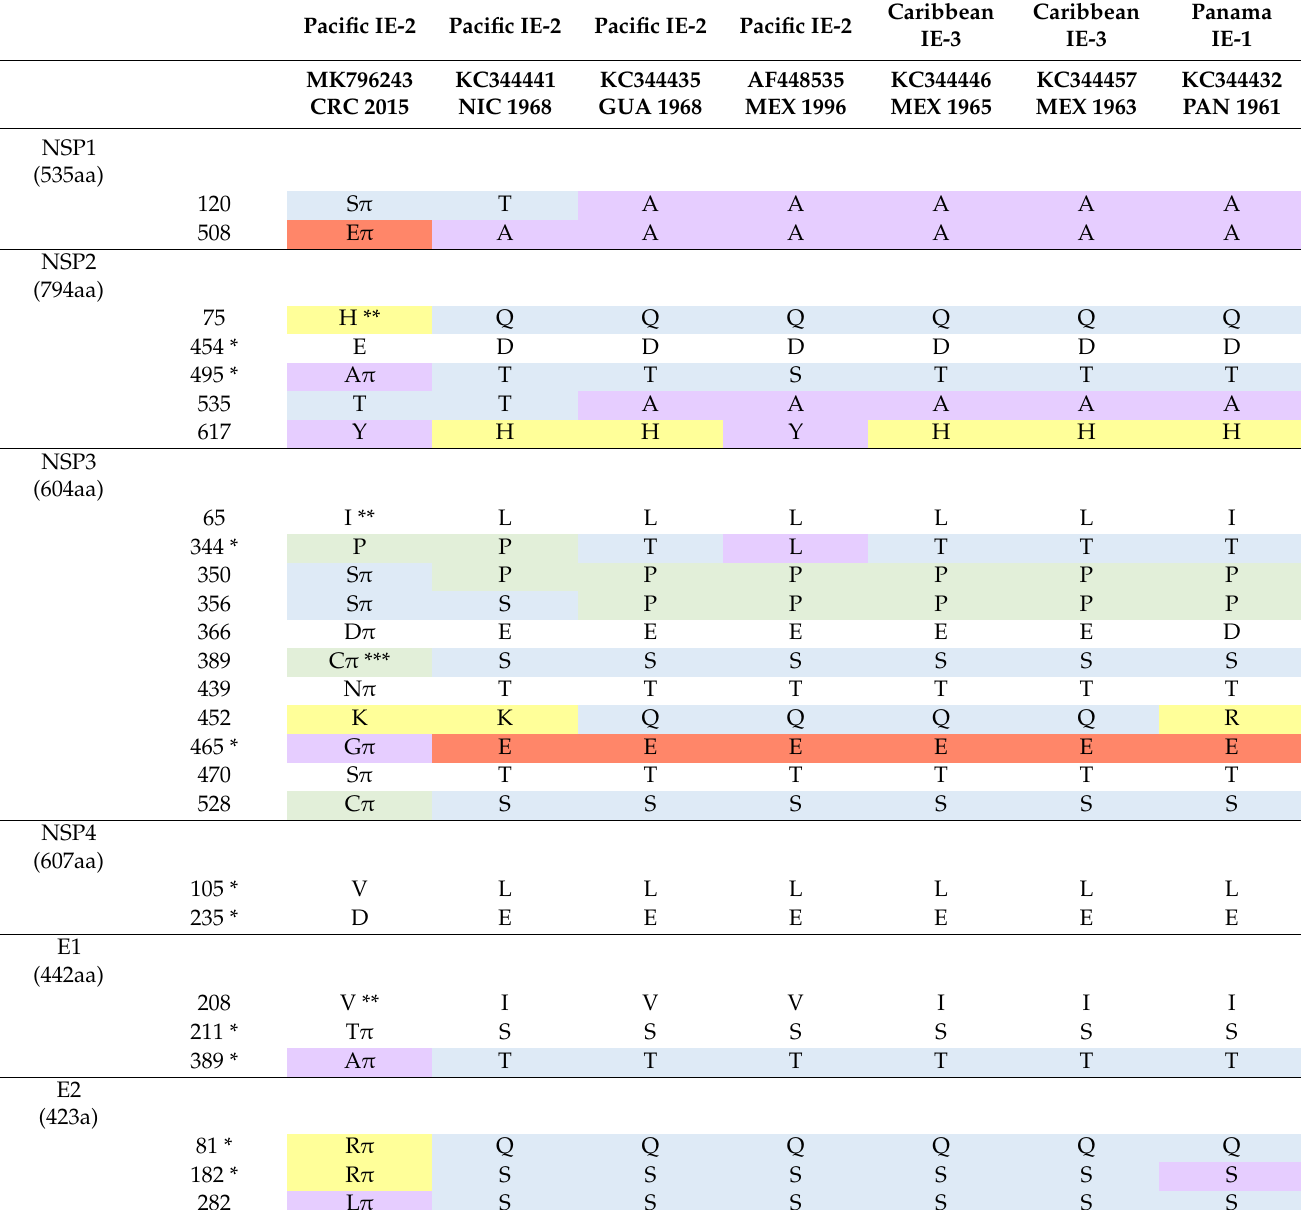
The colors highlighting amino acids represent changes in chemical properties: yellow, red, purple, and light blue indicate positively charged, negatively charged, hydrophobic, and polar amino acids, respectively, while green is either C, G, or P. The acidic E is changed to the hydrophobic A in position 508 of NSP1, the G is changed to the acidic E in position 479 of NSP3, in position 389 of E1 the hydrophobic A is changed with the polar T and in the 282 in E2 the hydrophobic is changed to the polar S. * the pervasive positive/diversifying selection sites according to FEL. ** Histidine (H) at position 75 of NSP2 is shared among all the sequences of the IAB, ID, and IC subtypes, Isoleucine (I) at position 65 of the NSP3 protein is shared with the 2 sequences IE-1 and all the sequences of the IAB, ID, and IC subtypes, Valine (V) at position 208 of the SPE1 protein is shared with 17 sequences of IE-2 group and all sequences of the IAB, 16/17 ID, and IC subtypes. *** In position 389 of the NSP3, the CR sequence has a C, while the subtypes IAB and IC have a